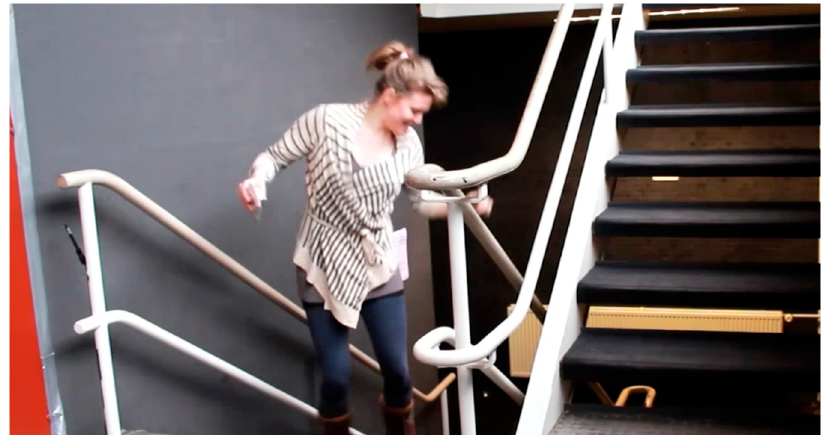
Figure 4. Social Stairs elicited various types of emerging behaviour. Jumping and dancing on the stairs to create music was one of the most common ones.